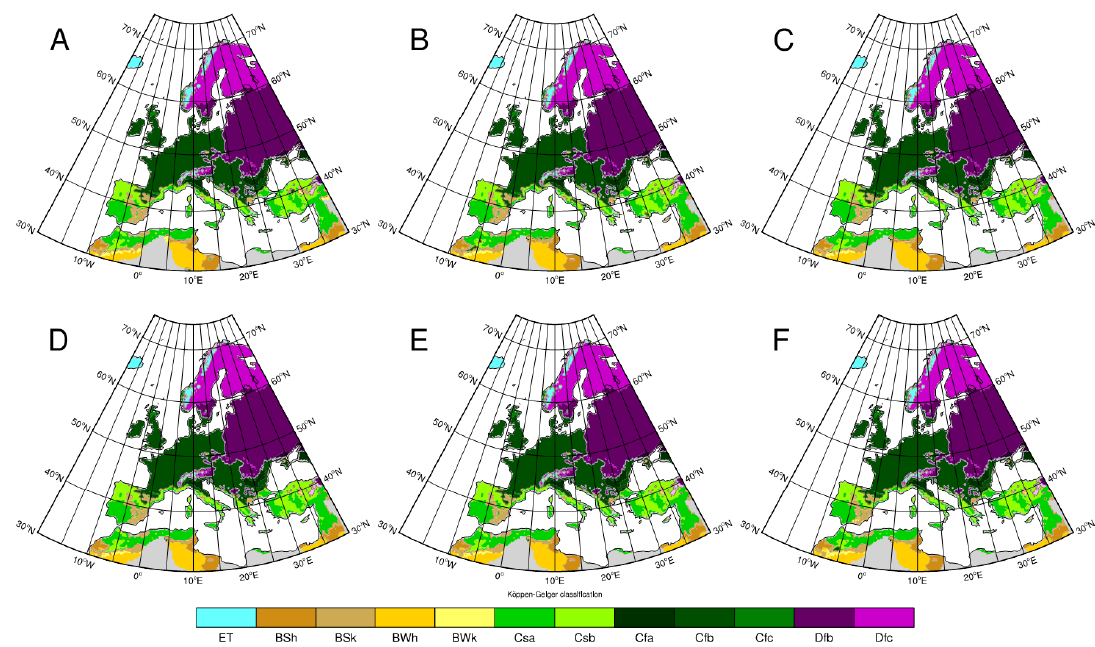
Figure 5. Simulated K-G climate classification according to E-OBS ( A ) and power transformation of precipitation and variance scaling of temperature correction in ALADIN ( B ), HIRHAM ( C ), RegCM ( D ), RAMCMO2 ( E ) and RCA ( F ).